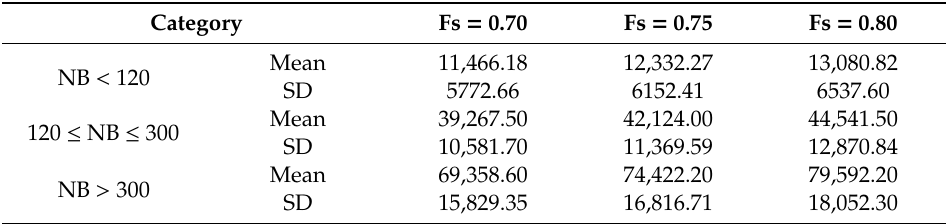
Table 4. Amount of CO 2 (ton / year) not emitted to the atmosphere.